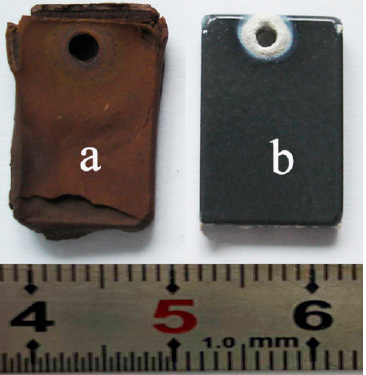
Figure 5. Macroscopic morphology of the substrate ( a ) and coated ( b ) sample after oxidation at 900 °C for 100 h.